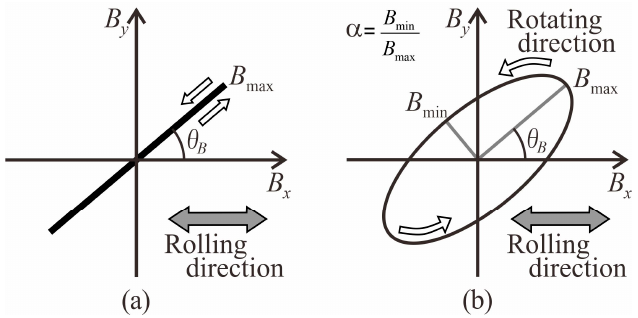
Figure 3. Definition of ( a ) alternating magnetic flux condition and ( b ) rotating magnetic flux condition.